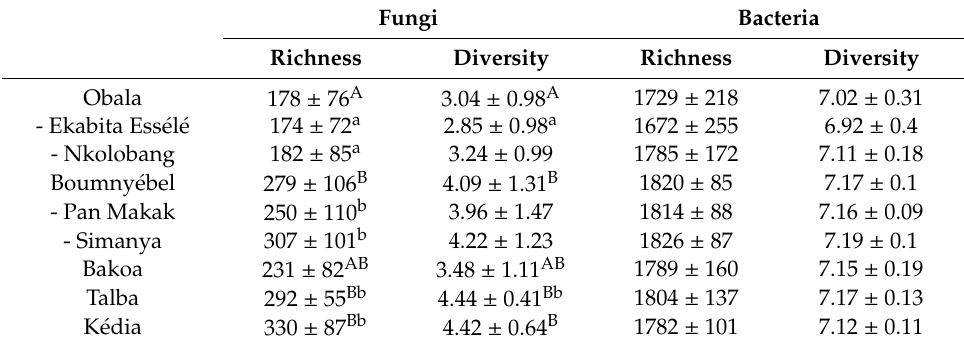
Table 3. Alpha diversity measures (mean ± standard deviation) for bacterial and fungal endophytes in leaves of T. cacao. Richness and diversity are represented by the number of observed zero-radius operational taxonomic units (zOTUs) and Shannon diversity index H’,